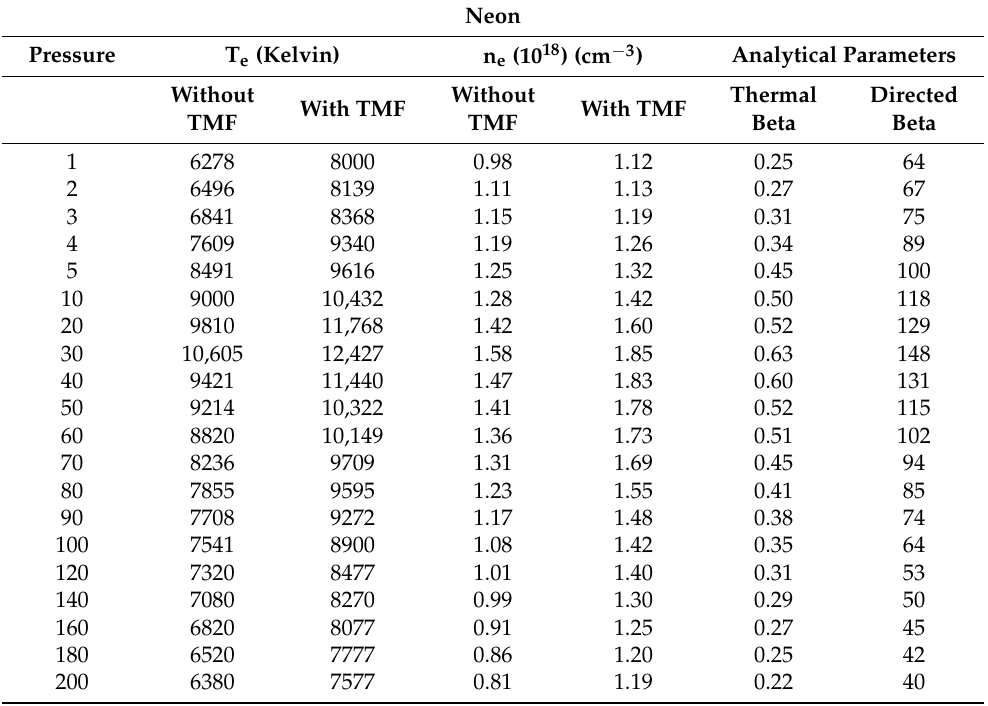
Table 3. Evaluated T e , n e , β t , and β d values for laser-irradiated Cu-alloy plasma at various Ne pressures in the presence and absence of